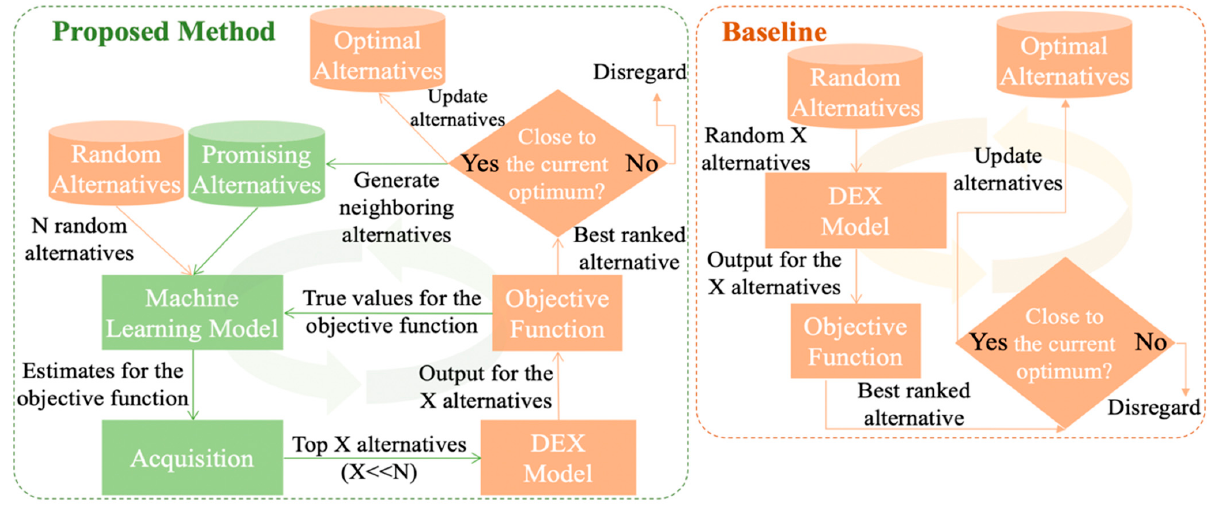
Figure 7. Proposed BAG-DSM method for generating alternatives ( left ) vs. naïve approach ( right ).